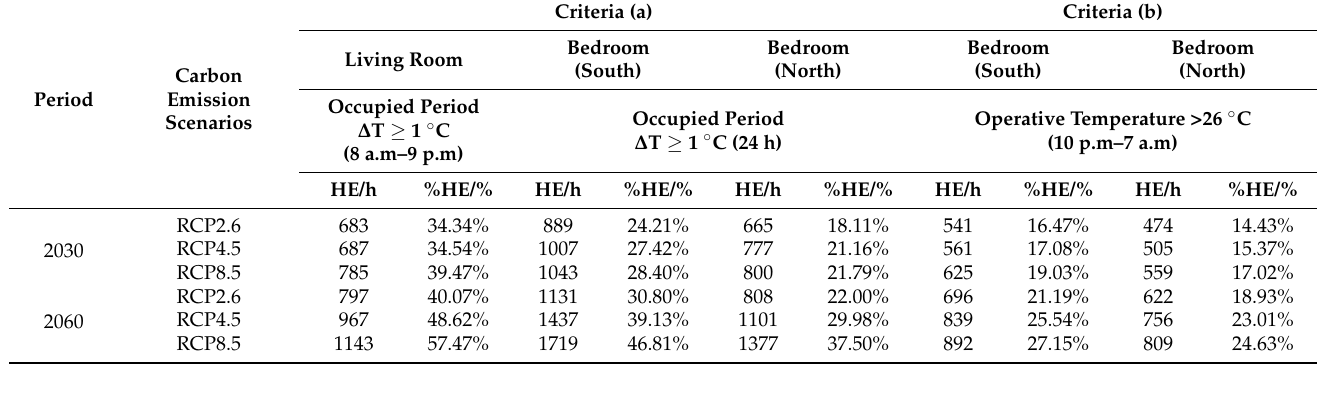
Table 7. Overheating hours of simulated rooms based on CIBSE in different carbon emission scenarios during summertime (May to September) for 2030 and 2060 based on CIBSE TM59.